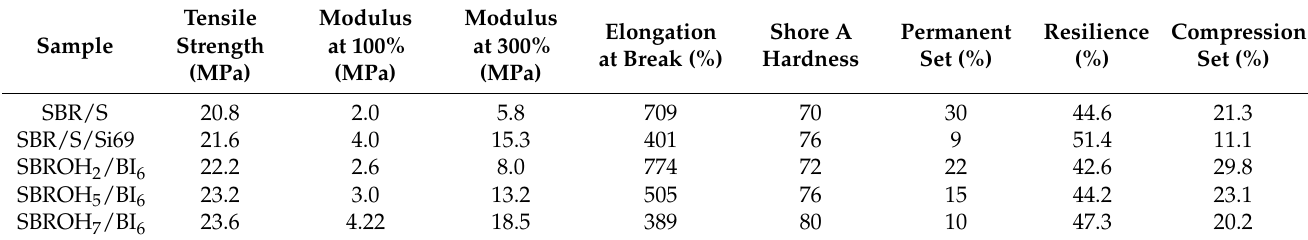
Figure 6. ( a ) crosslink density, ( b ) curing curves, and ( c ) stress − strain curves of SBROH x cured by 6 phr BI. Table 2. Mechanical properties of SBROH/BI/silica composites.